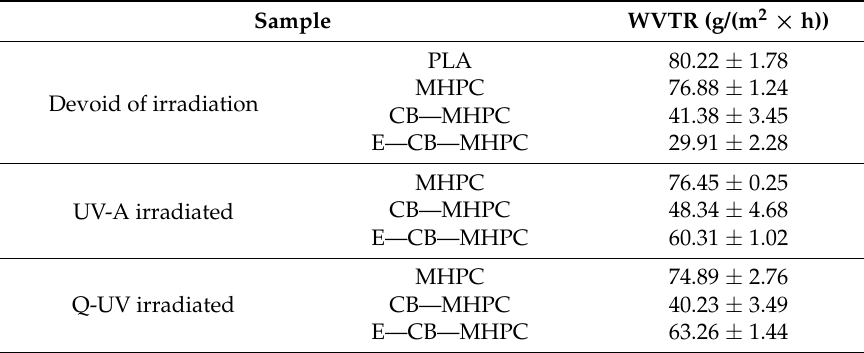
Table 1. The water permeability of PLA films before and after